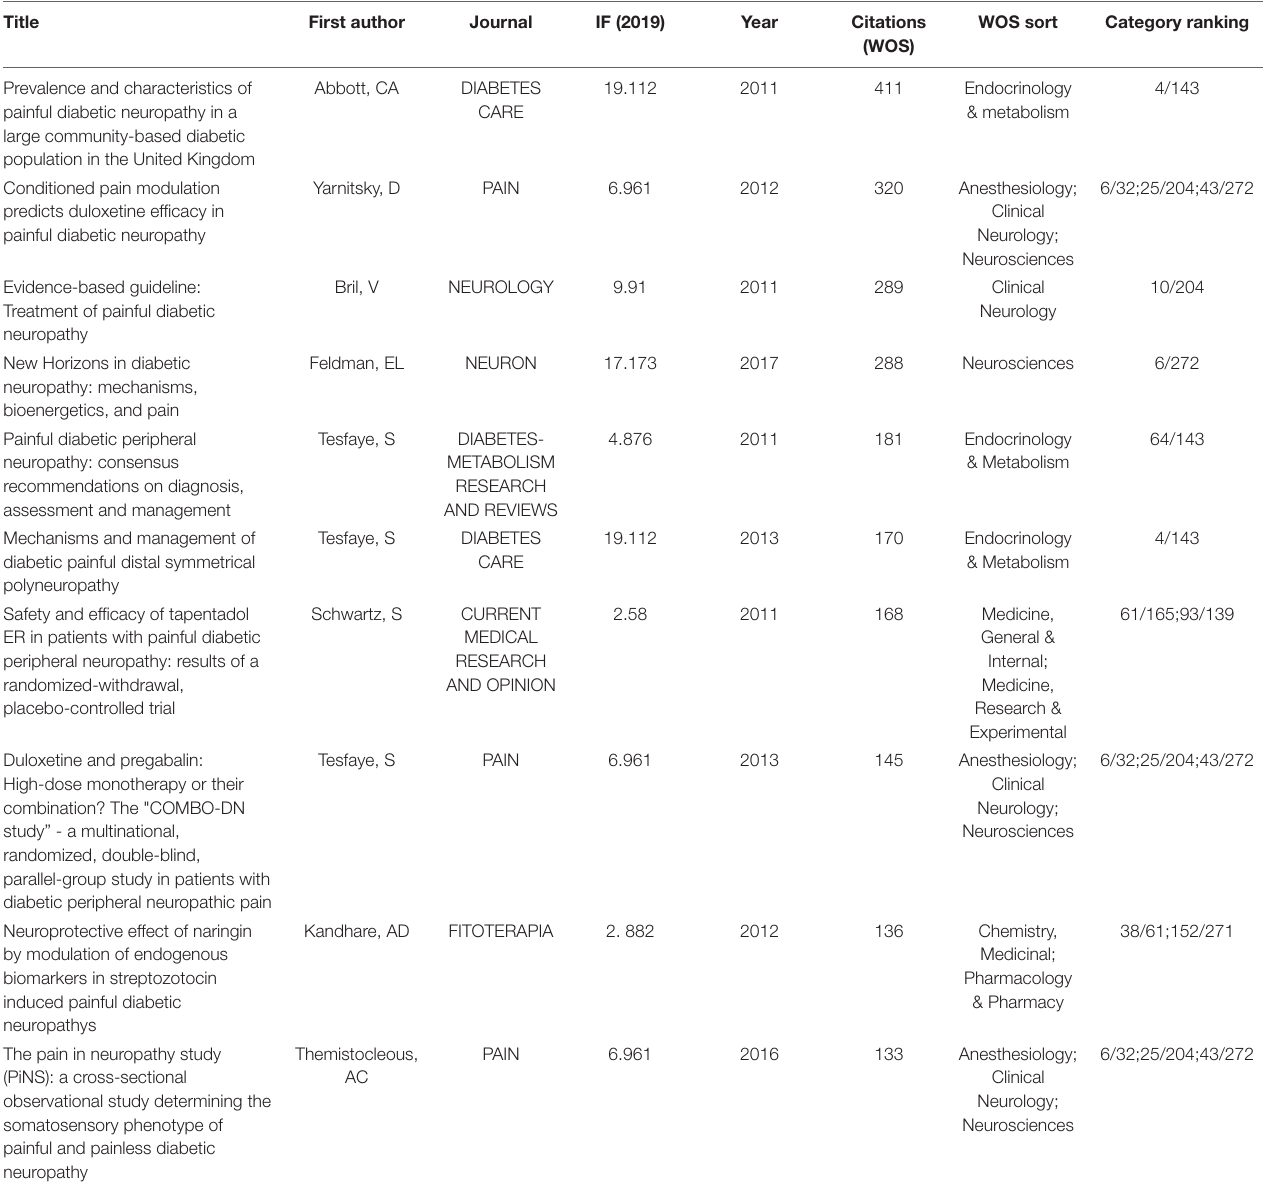
TABLE 3 | The top 10 papers with the most citations on DPNP